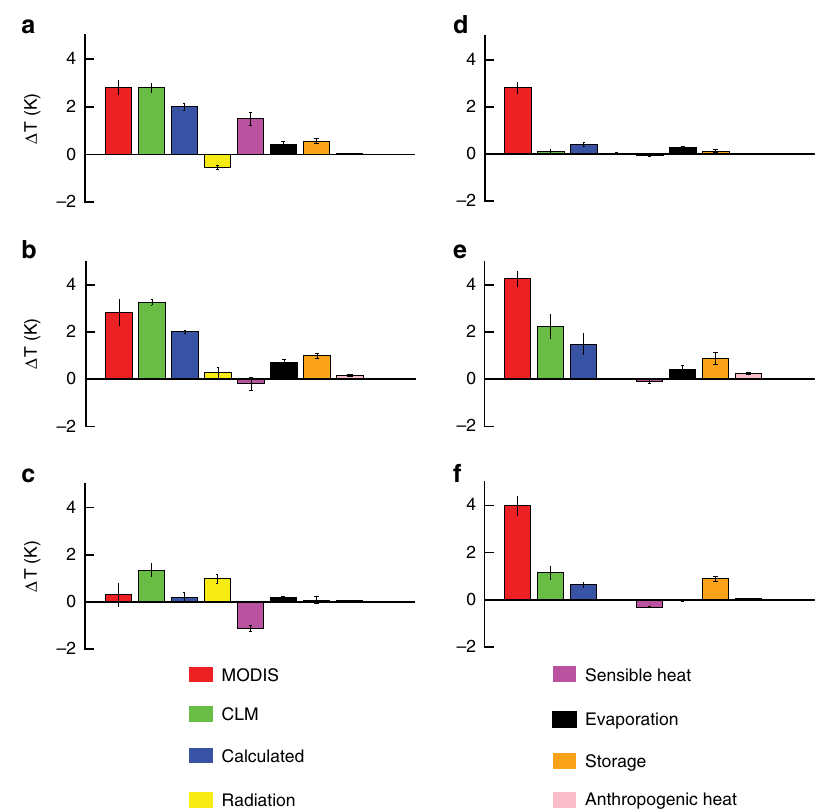
Figure 2 | Urban Heat Island attribution and comparison with satellite observation. Daytime Urban Heat Island (UHI) attribution in ( a ) humid region, ( b ) semi-humid region and ( c ) semi-arid region. Nighttime UHI attribution in ( d ) humid region, ( e ) semi-humid region and ( f ) semi-arid region. The red bar denotes the MODIS-derived UHI. The green bar denotes the UHI intensity determined online by the CLM model. The blue bar denotes the intensity calculated offline as the sum of the component contributions (changes in albedo as part of the radiation term (yellow bar), efficiency of sensible heat convection (magenta bar), evaporation (black bar), heat storage (orange bar) and anthropogenic heat release (pink bar) equation (2)) but excludes the haze contribution. Error bars are ± 1